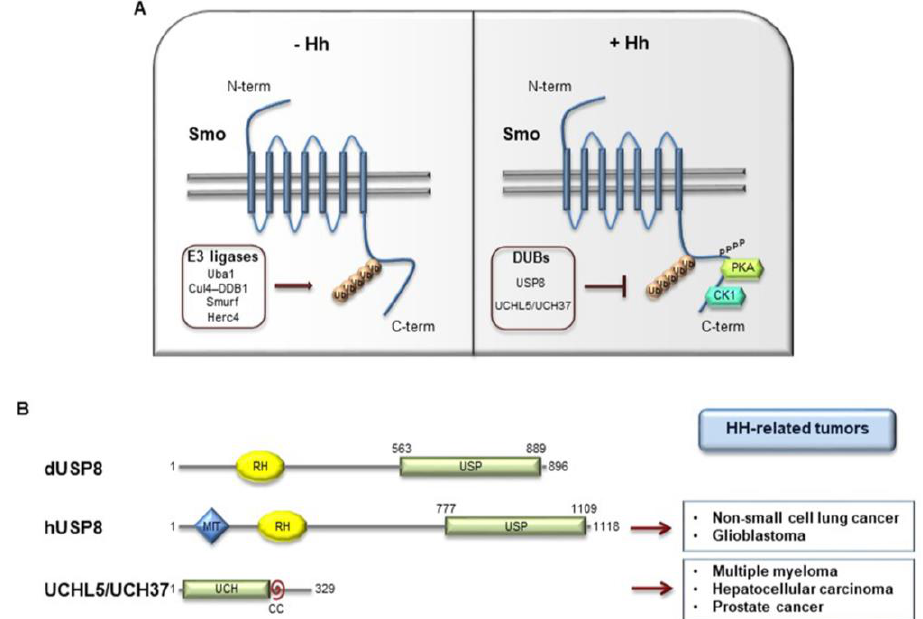
Figure 4. ( A ) E3-ubiquitin ligases and DUBs involved in Smo regulation. In Drosophila , when the Hh pathway is OFF, Smo is ubiquitylated by multiple E3 ligases (Uba1, Cul4-DDb1, Smurf, Herc4) that induce Smo lysosome or proteasome degradation. Conversely, when Hh signaling is activated, Smo is deubiquitylated by USP8 or UCHL5 / UCH37 and then accumulated on cell surface, where it is active. This event is induced by PKA- and CK1-phosphorylation at the C-terminal region of Smo. ( B ) Structure of Drosophila dUSP8, human hUSP8, and UCHL5 / UCH37. The boxes on the right indicate the main HH-related tumors in which USP8 and UCHL5 / UCH37 are involved. USP: ubiquitin specific protease domain; MIT: microtubule interacting and tra ffi cking molecule domain; RH: Rhodanese-like